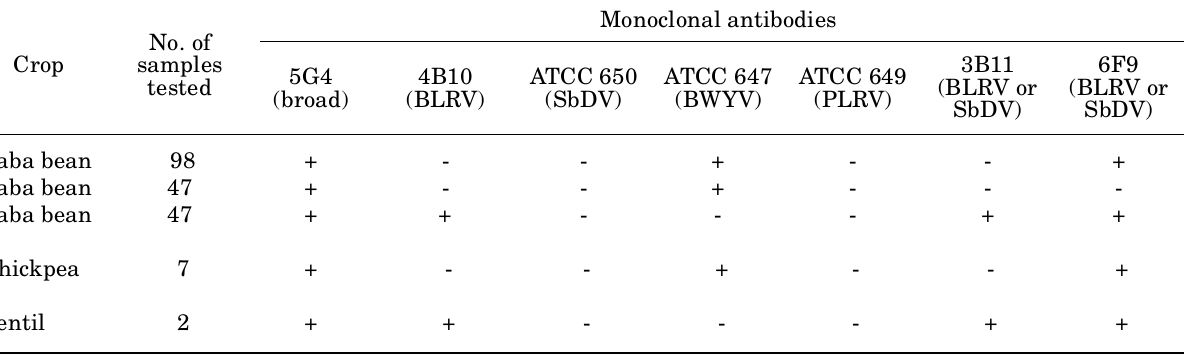
Table 3. Reaction with specific monoclonal antibodies of legume samples infected by luteoviruses collected from Tunisia during April 3–12,